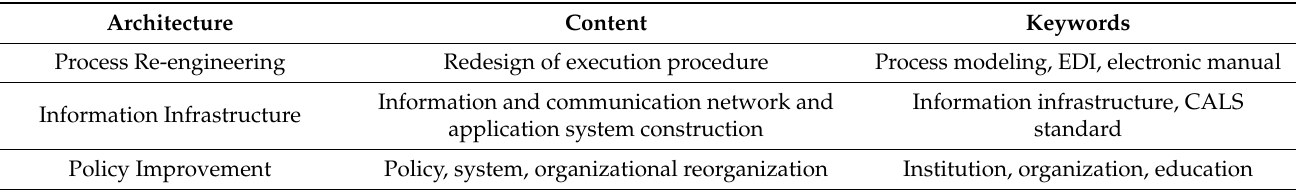
Table 3. Construction CALS basic structure (Architecture of CALS).